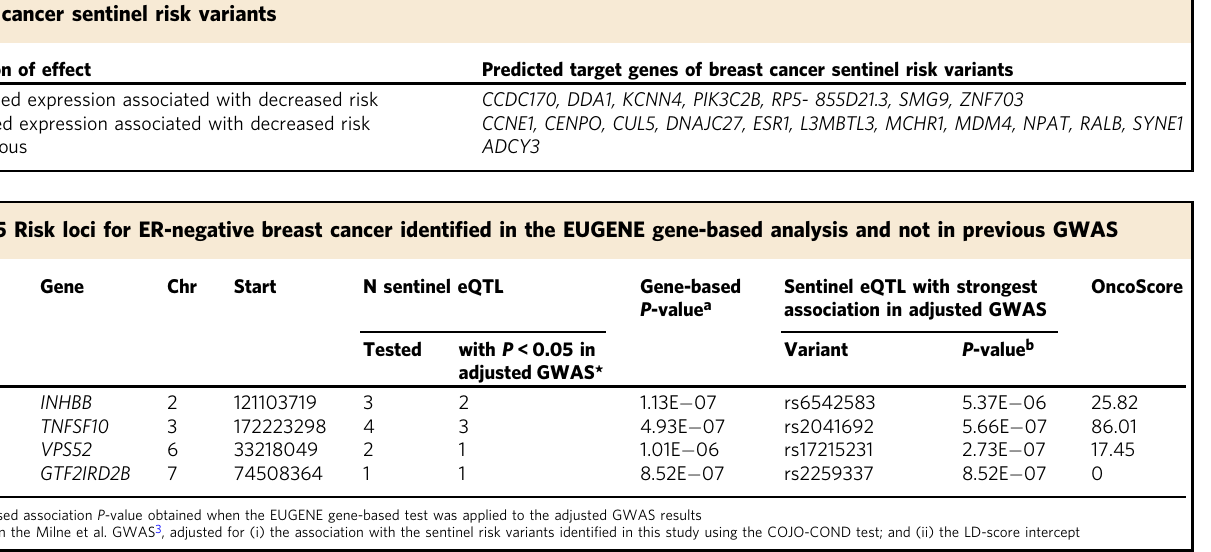
Table 4 Directional effect of genetically-determined gene expression on disease risk for predicted target genes of ER-negative breast cancer sentinel risk variants